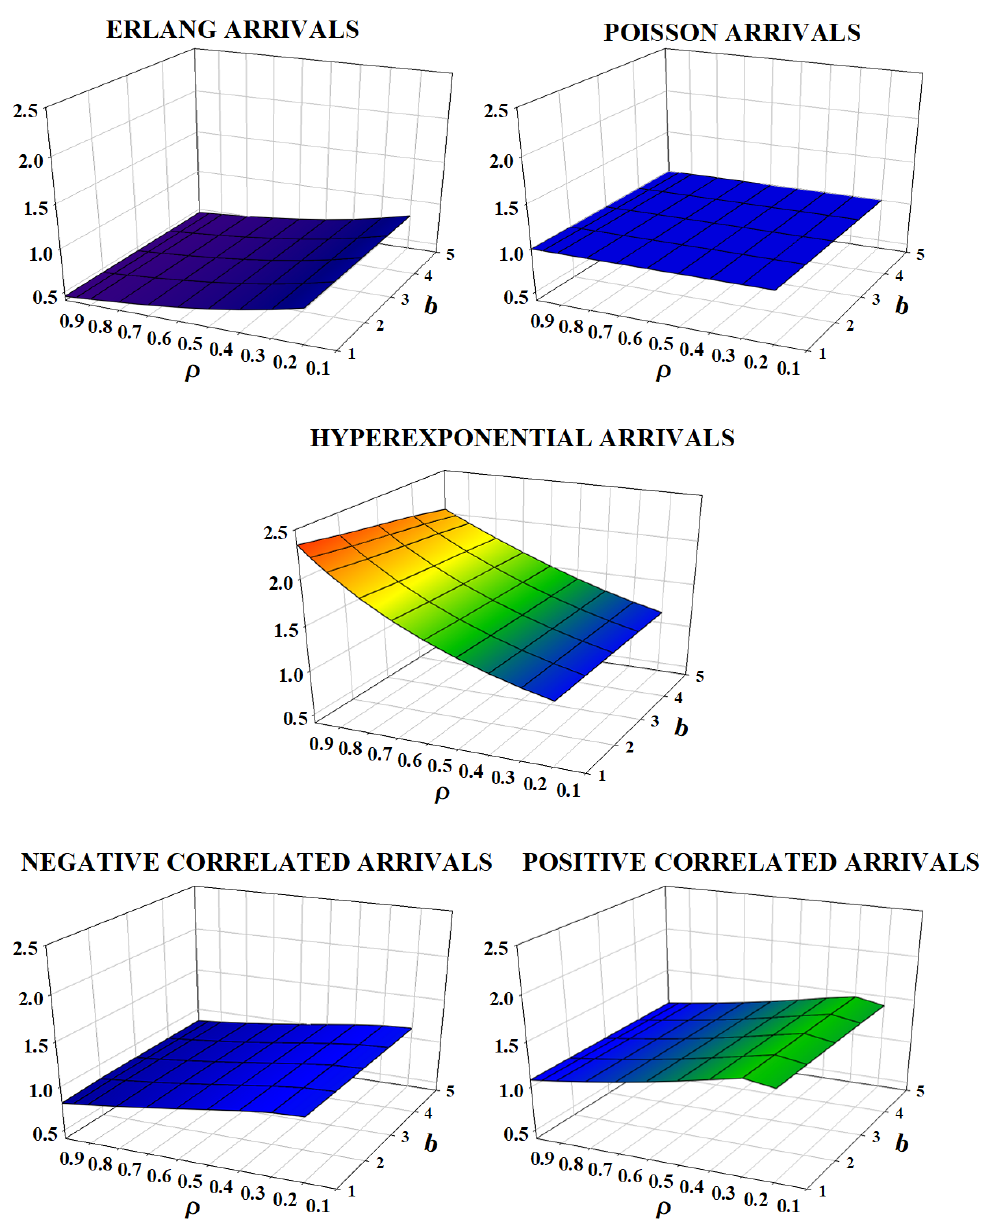
Figure 3. Mean idle time ( µ (cid:48)